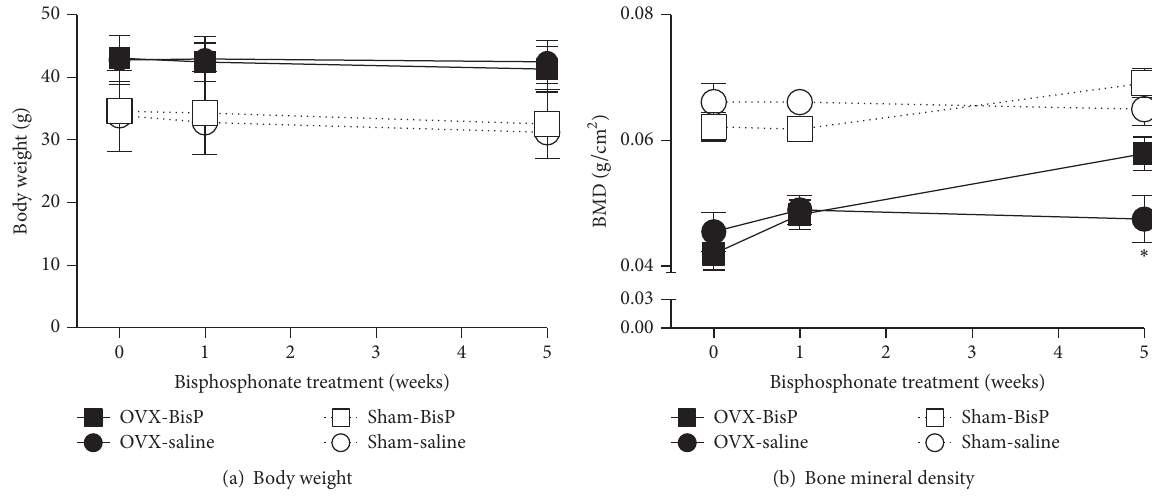
Figure 3: Efficacy of chronic bisphosphonate (pamidronate) treatment on body weight and bone mineral density. Mice were treated with pamidronate (0.25 mg/kg) or a saline vehicle 5 days/week for 5 weeks, beginning 6 months after undergoing ovariectomies or sham surgeries. Pamidronate has no effect on body weight after either 1 or 5 weeks of treatment (a) but results in a significant reversal of ovariectomy- induced bone mineral density decreases after 5 weeks of treatment that is not observed after 1 week of treatment (b). Data are expressed as means ± standard error of the mean. OVX: ovariectomized; BisP: bisphosphonate (pamidronate); ∗ 𝑃 < 0.05 ; and OVX with bisphosphonate pamidronate versus saline vehicle control, two-way repeated measures analysis of variance (factors = group × time) followed by Tukey’s test for multiple